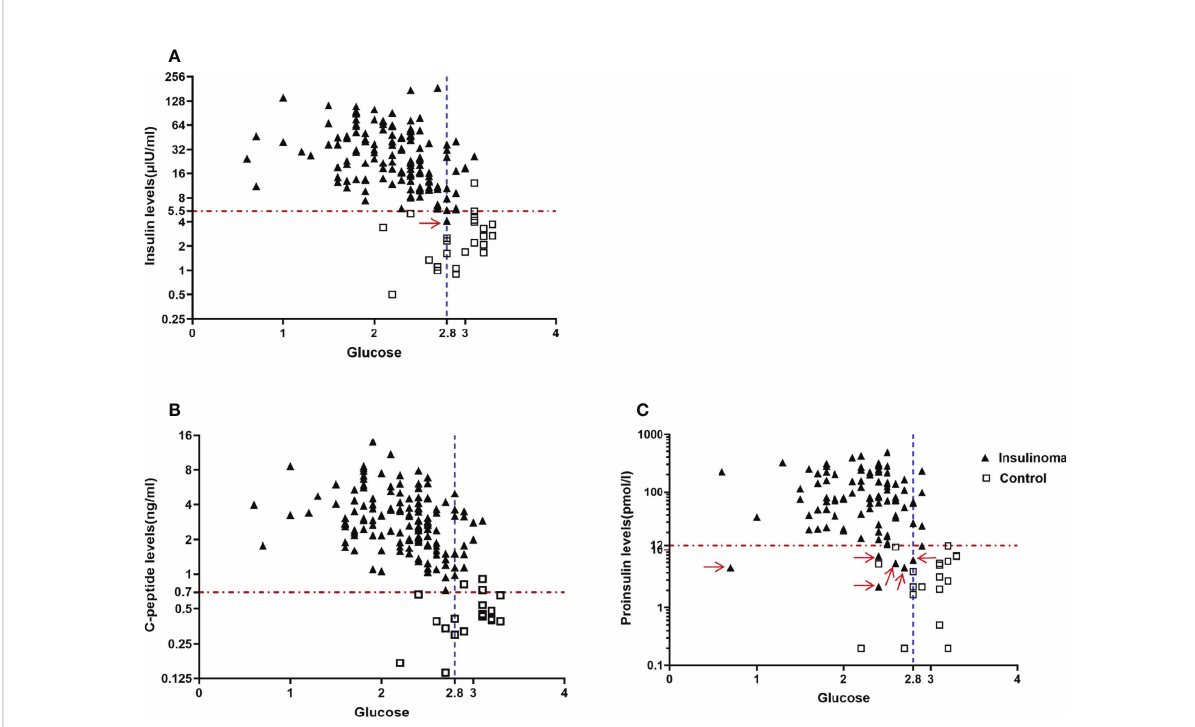
FIGURE 1 New and optimal diagnostic criteria for endogenous hyperinsulinemic hypoglycemia based on our cohort. (A) An end-of-fast insulin level>=5.5 m IU/ml with concomitant blood glucose level<=2.8mmol/L missed one patient with insulinoma(Red arrow), (B) An end-of-fast C- peptide level>=0.7ng/ml with concomitant blood glucose level<=2.8mmol/L completely distinguished the patients with insulinoma from the control group, and (C) An end-of-fast proinsulin >=12pmol/L with concomitant blood glucose level<=2.8mmol/L missed 6 patients with insulinoma (Red